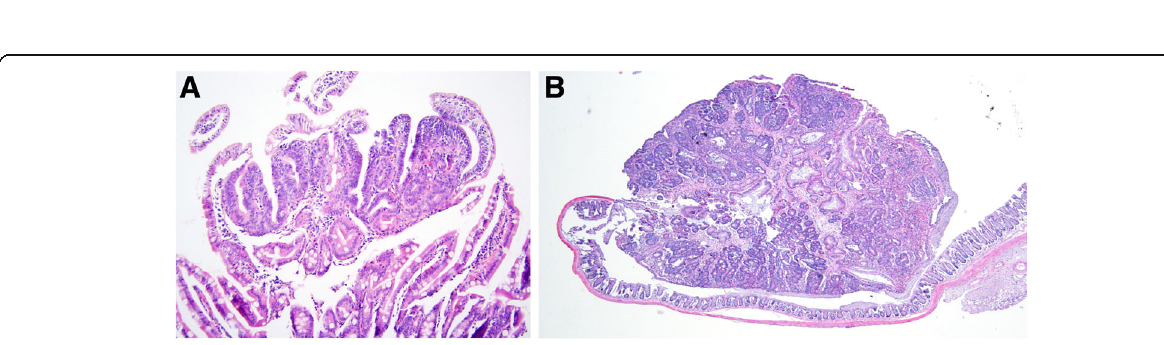
Fig. 5 a Small intestinal adenomas in Apc Min/+ mice push into the intervillus spaces as they grow. Note preservation of normal epithelium over much of the adenoma. b A pedunculated colonic adenoma in an Apc 1638N/+